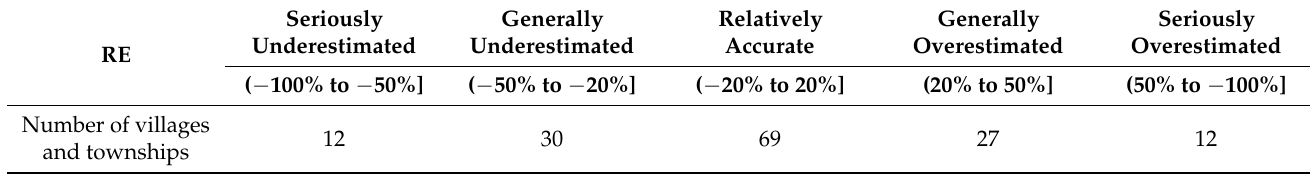
Table 4. Relative error (RE) classification for villages and